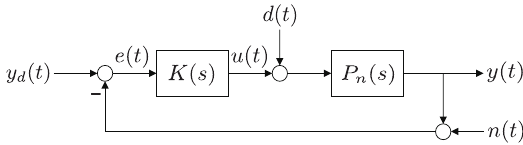
Figure 11. Block diagram of the PID feedback control